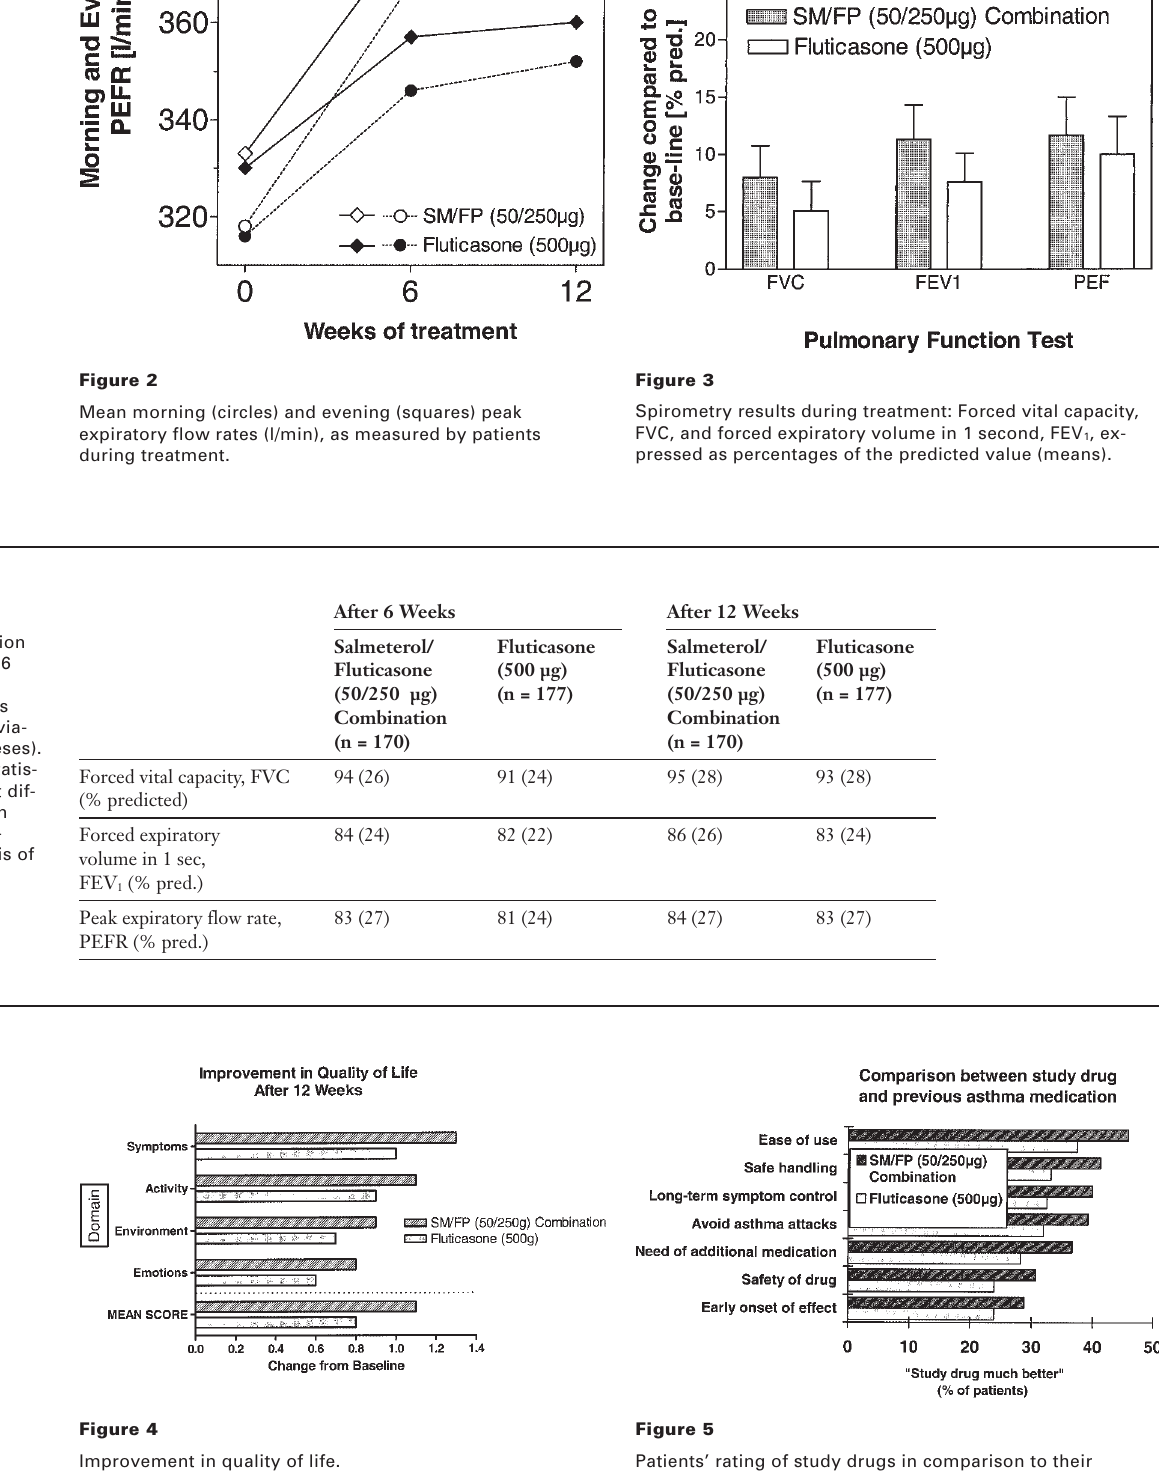
Figure 5 Patients’ rating of study drugs in comparison to their previous asthma